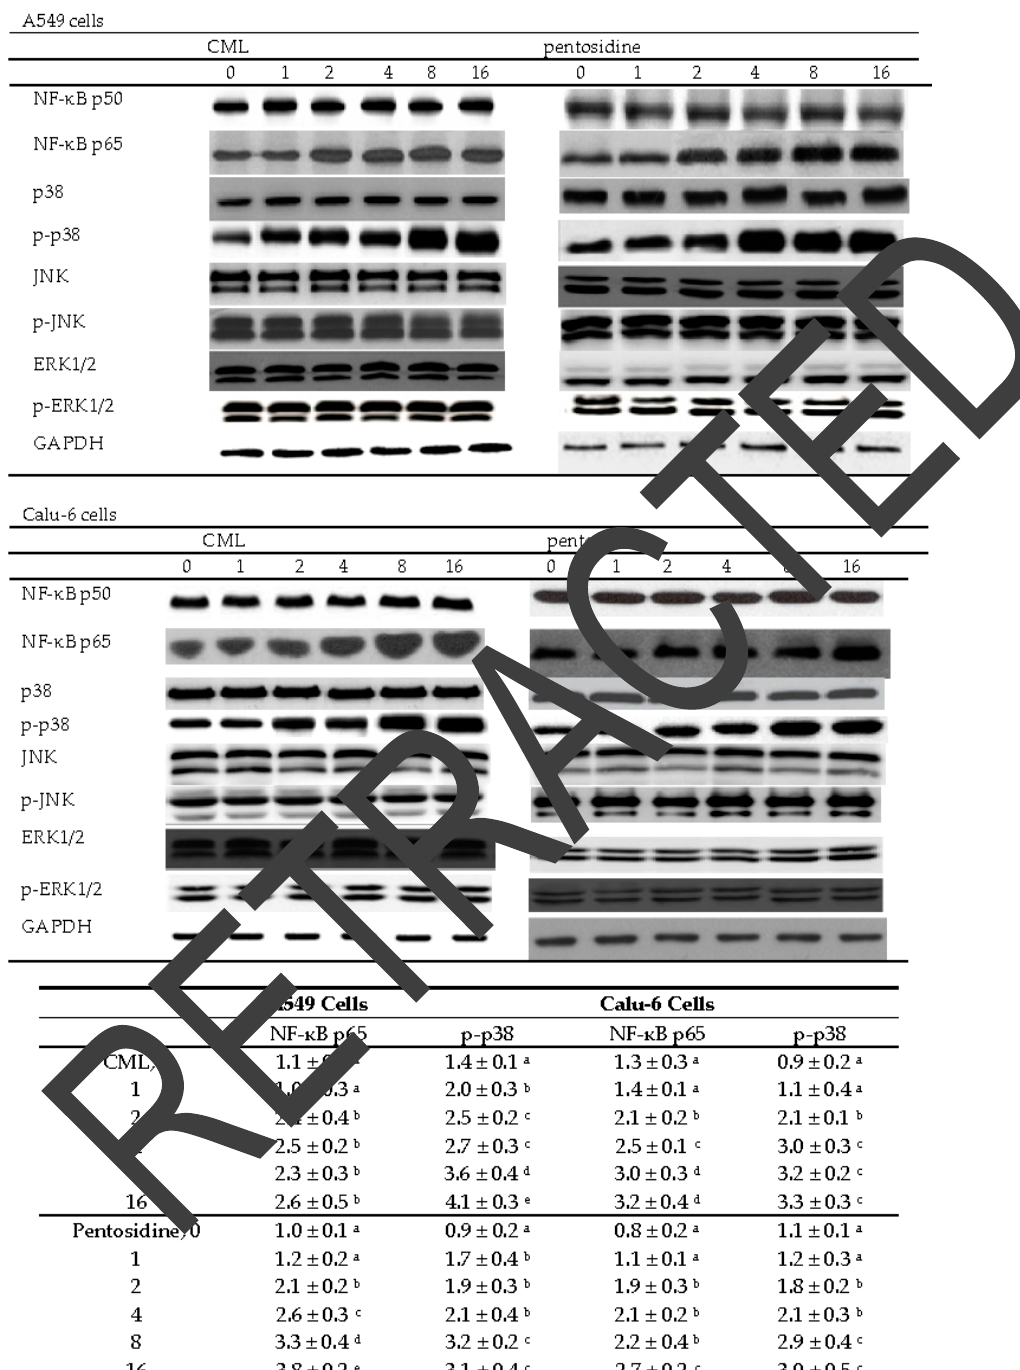
Figure 4. Effects of CML or pentosidine at 0 (control), 1, 2, 4, 8 or 16 μ mol/L upon protein expression of NF- κ B and MAPK in human A549 and Calu-6 cells. Cells were exposed to CML or pentosidine for 18 h at 37 °C. Data are mean ± SD ( n = 10), and shown in the following table. a–e Means within a column without a common letter differ, p < 0.05.